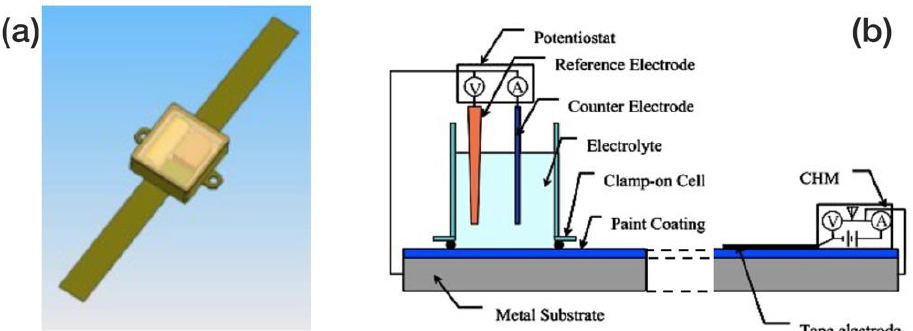
Figure 5. ( a ) An illustration of the miniaturised coating health monitor with tape electrodes. ( b ) A comparison to a conventional flat cell for EIS measurements [78].